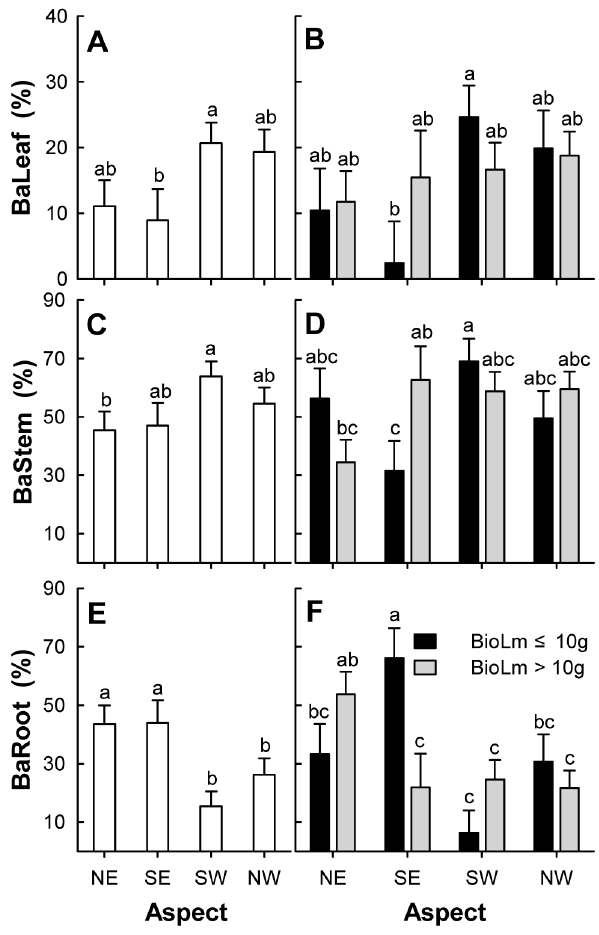
Figure 3. Effects of aspect and size class of layering module on biomass allocation of 3 modules of Nitrariatangutorum . BaLeaf, BaStem, BaRoot and BioLm represent biomass allocation of leaf (%) (A and B), biomass allocation of stem (%) (C and D), biomass allocation of root (%) (E and F) and layering biomass (G), respectively; Open bars (A, C and E) are grand means of four aspect sections across two size classes of layering. Grayscale bars (B, D and F) are means of four aspect sections and two size classes of layering combinations; Error bars represent standard errors of the means; the letters above the error bar are groupings from Duncan’s multiple range tests. Bars with a different letters are significantly different at P =0.05.